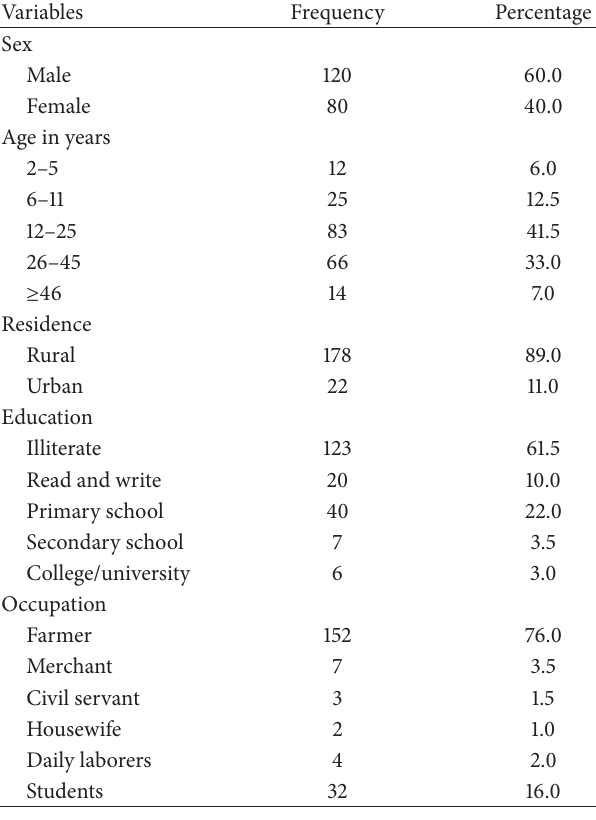
Table 1: Sociodemographic data of study subjects in Ayinba Health Center, Northwest Ethiopia, April to May 2013.